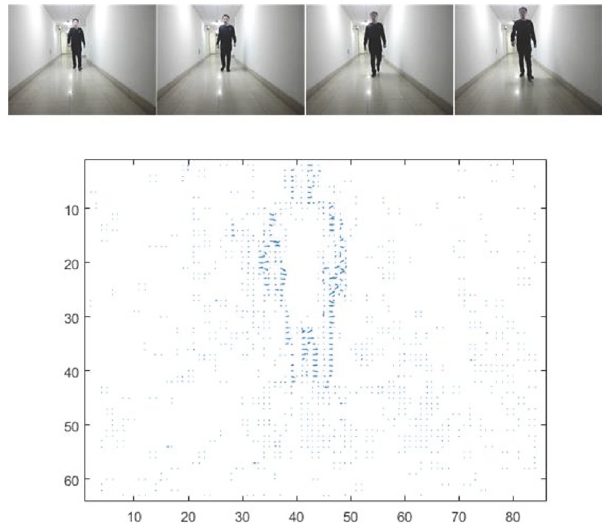
Figure 7: Illustration of cameras in intelligent space